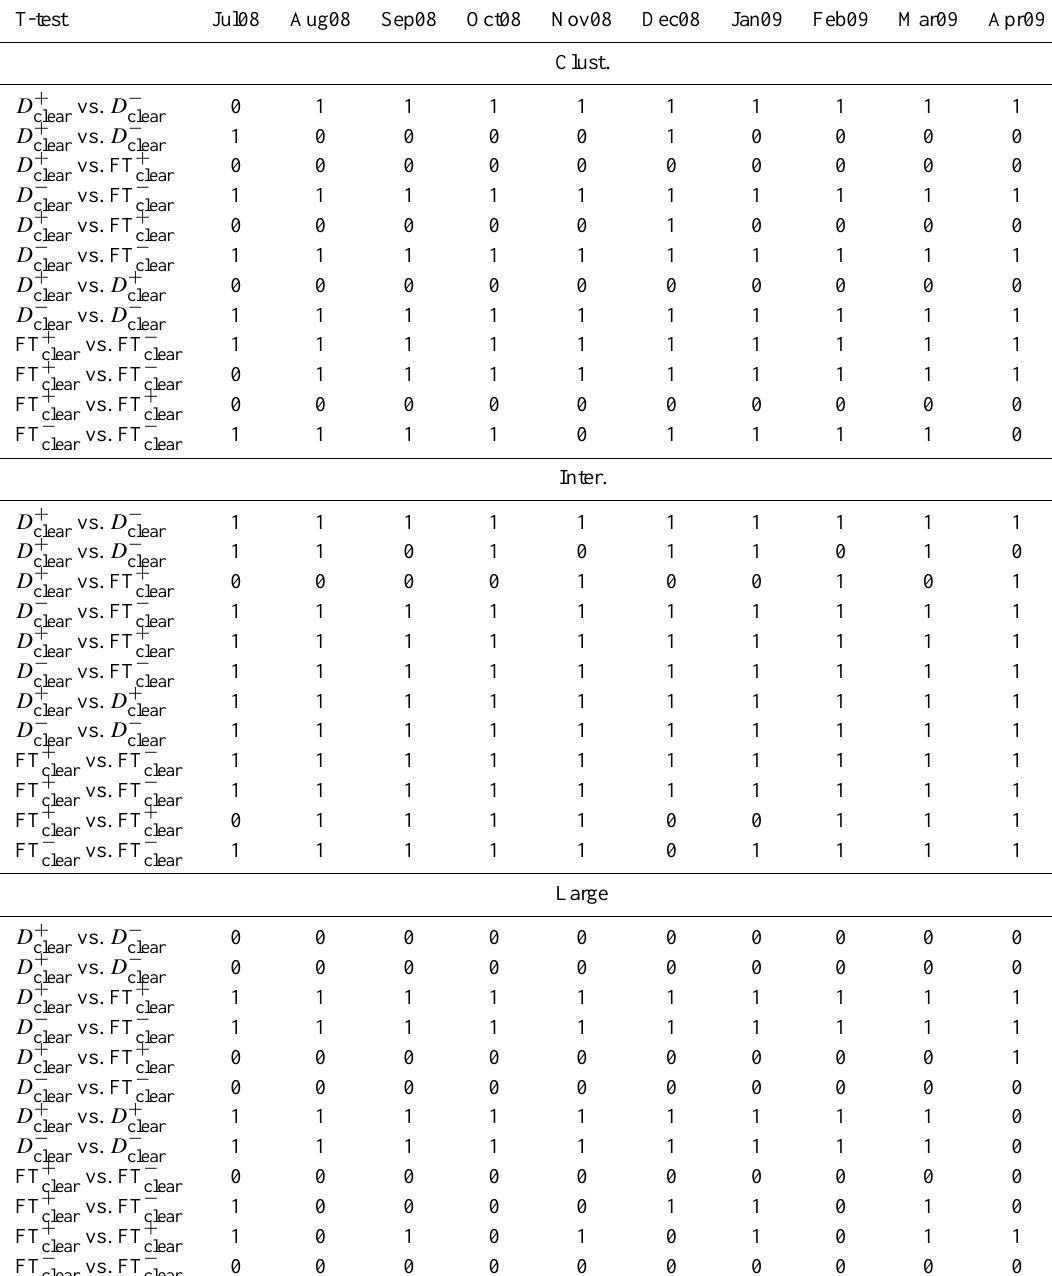
Table A2. T-test results for “diurnal vs. FT” and “clear sky vs. cloudy” conditions for different size classes. a “1” indicates that a significant difference exists between the values of the mean of the two considered data sets, a “0” means that the observed difference is statistically